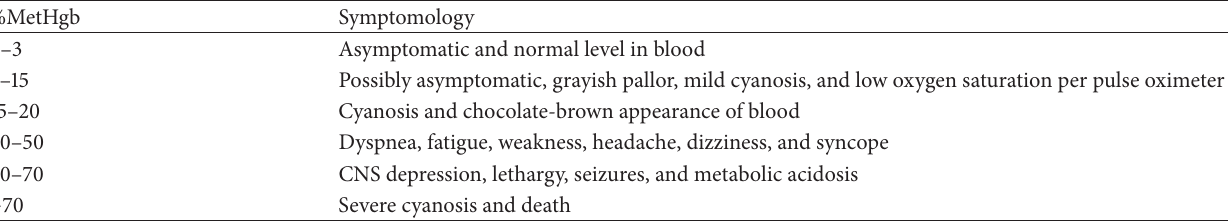
Table 2: The clinical manifestation of methemoglobinemia [1,